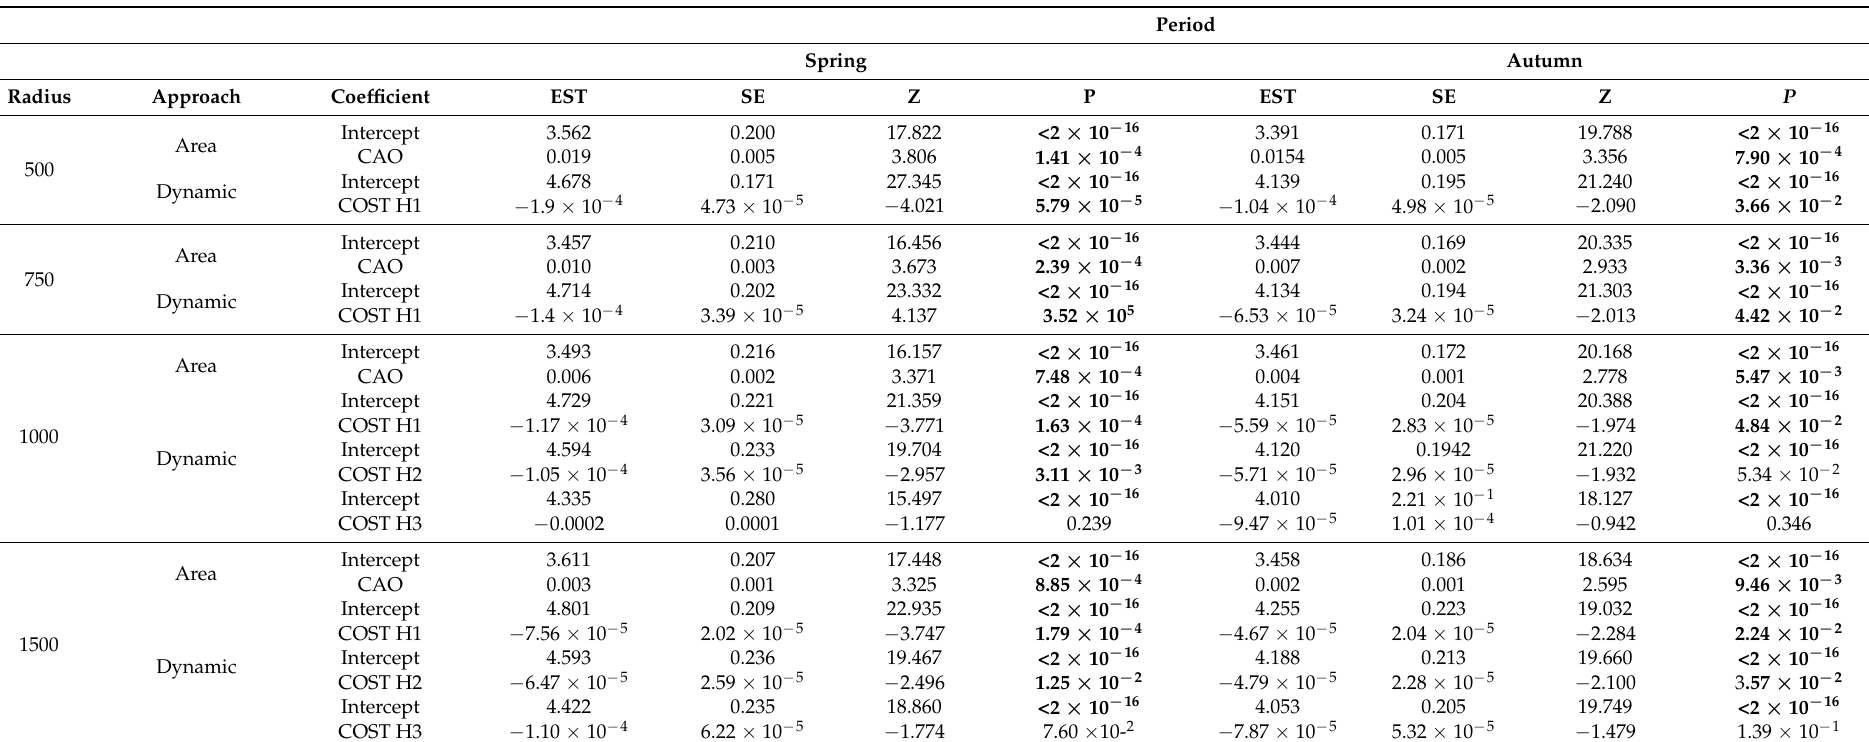
Table 2. Estimated regression coefficients (EST), adjusted standard errors (SE), Z and P values from glmmTMB for the comparison of the area and dynamic approaches regarding landscape effect on Bactrocera oleae abundance in 2015. Abundance data were pooled in two periods. Generalized lineal mixed models were fitted with a negative binomial distribution and link function log. Olive grove area (CAO) was used as the explanatory variable for the area approach, and cost–distance (COST) for the dynamic approach. Both CAO and COST were calculated at four radii around the sampled olive groves (500, 750, 1000 and 1500 m). H1, H2 and H3 after COST refer to hypotheses 1, 2 and 3 respectively (see text for details). p values < 0.05 indicated in